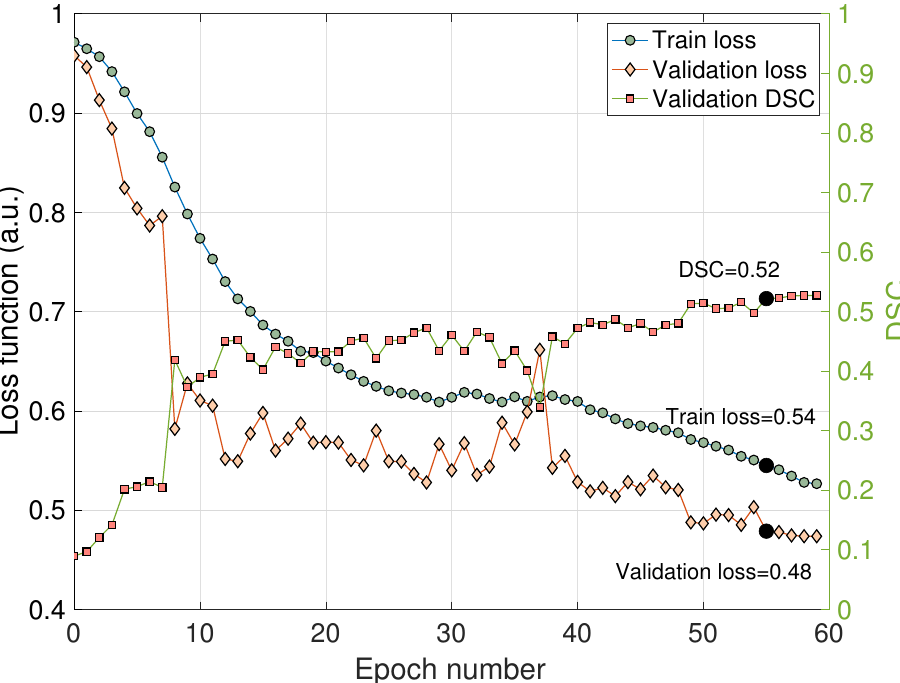
Figure 3. Train and validation losses (left axis) and Dice scores (DSC) (right axis) depicted as a function of epoch number. The train loss is smoothly decreasing, indicating numerical stability of the algorithm. The Dice score reaches a plateau, suggesting an optimal epoch number of 55 (black, solid dots). This epoch number yields optimal training performance of the network while minimizing the risk of over-training. a.u. = arbitrary